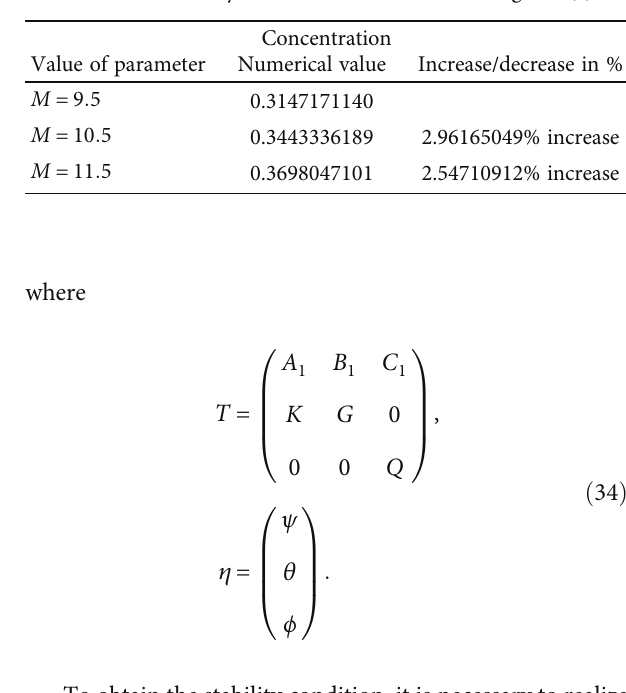
Table 5: Variability of the curve when Y = 1 in Figure